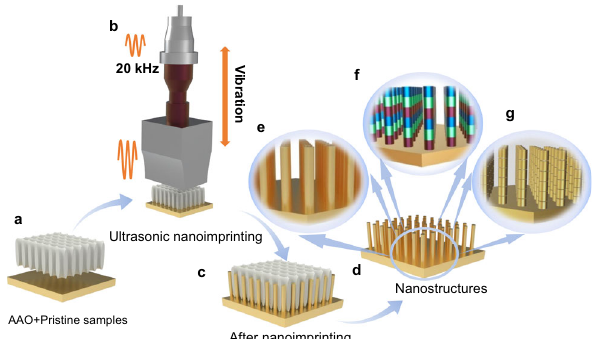
Fig. 1 Schematic of ultrasonic nanoimprinting of one-dimensional nanostructures. a AAO mold and metal foil were taken as examples. b Ultrasonic nanoimprinting process. c Stack of mold and metal foil after nanoimprinting. d Metal foil with nanostructures after demolding. e Nanowires/nanorods, f one-dimensional heterojunctions, and ( g ) nanowires with multiple nanogaps imprinted on substrate